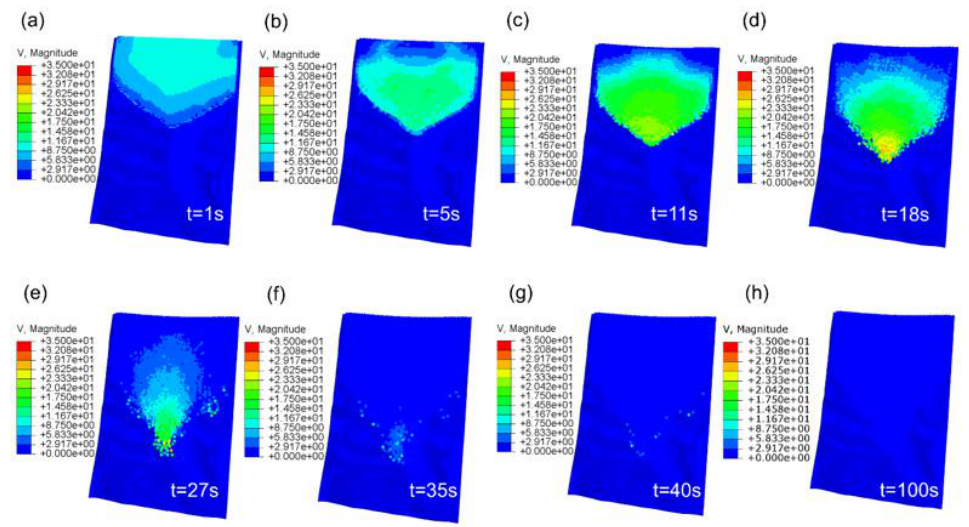
Figure 12. Velocity contours of the landslides for the full high waste dump at ( a ) t = 1 s; ( b ) t = 5 s; ( c ) t = 11 s; ( d ) t = 18 s; ( e ) t = 27 s; ( f ) t = 35 s; ( g ) t = 40 s; and ( h ) t = 100 s.